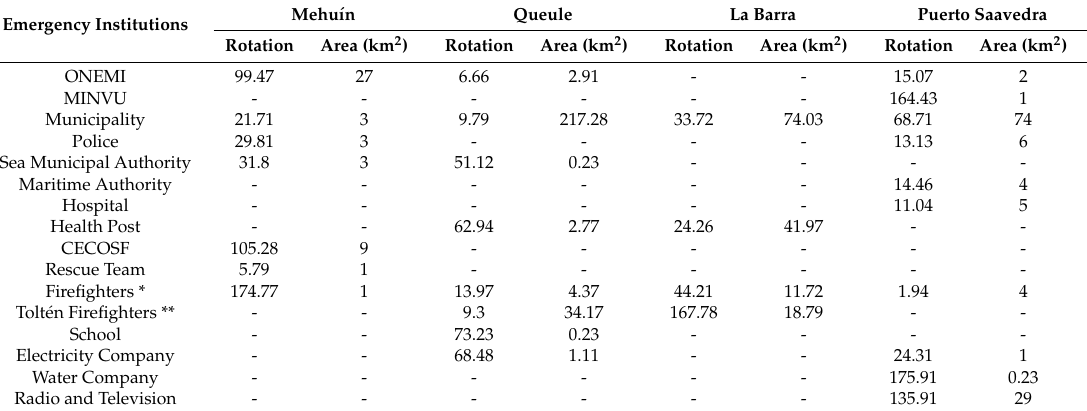
Table 2. Area of influence of the standard deviation